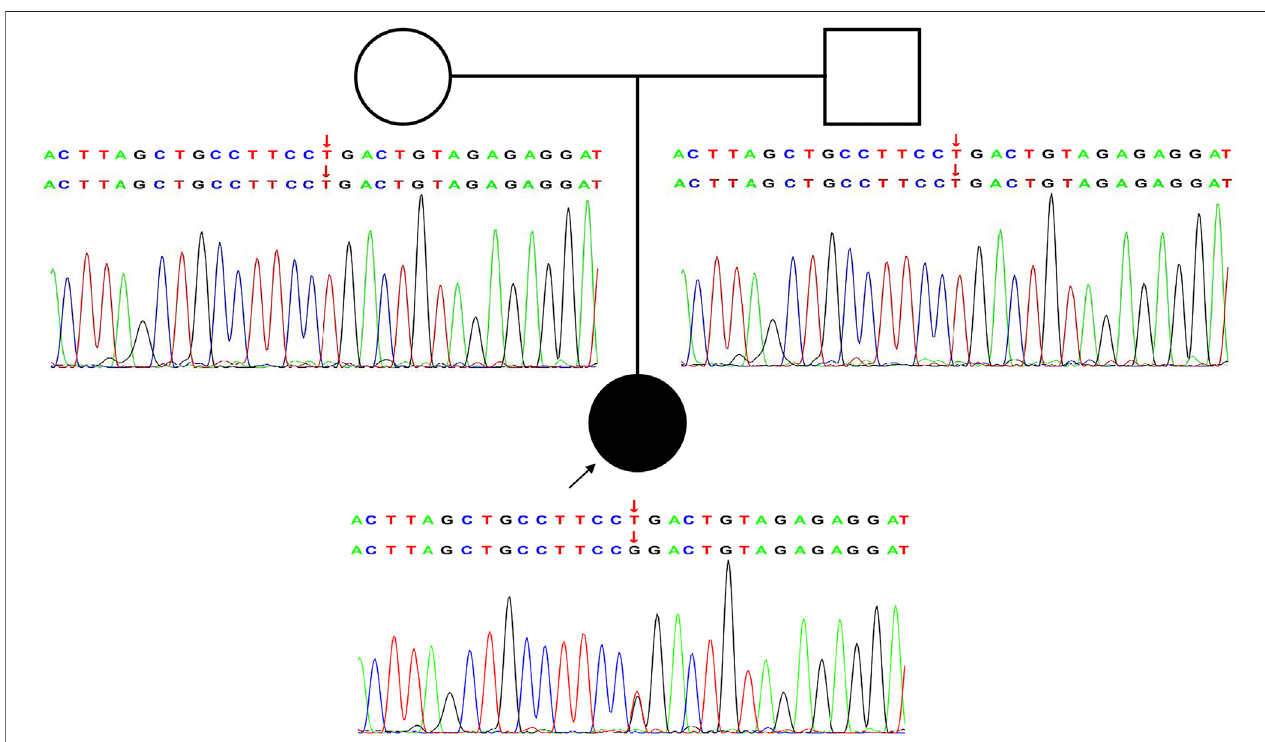
FIGURE1 | Novel heterozygous de novo GRIA2 mutation causes NEDLIB. Pedigree and Sangersequencingvalidationfor the GRIA2 NM_001083619.1: c.1934T > G (p.Leu645Arg) variant in an affected individual compared with healthy parents.